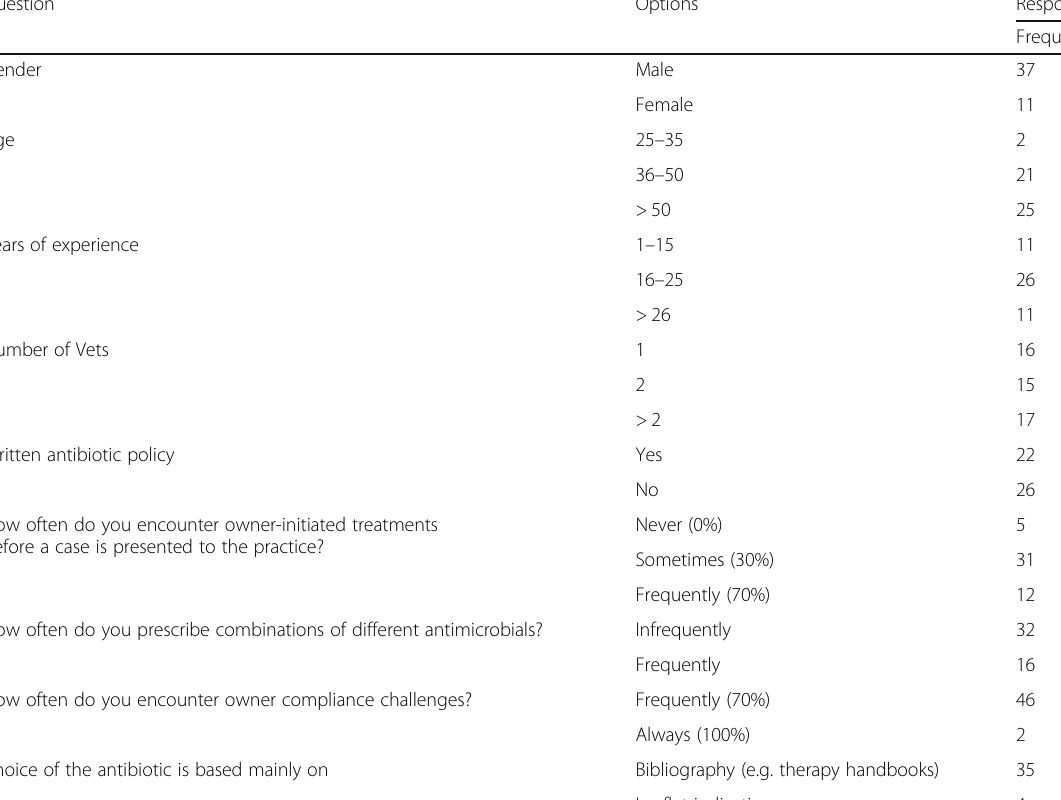
Table 1 Questionnaire responses (frequency and percentage) by the 48